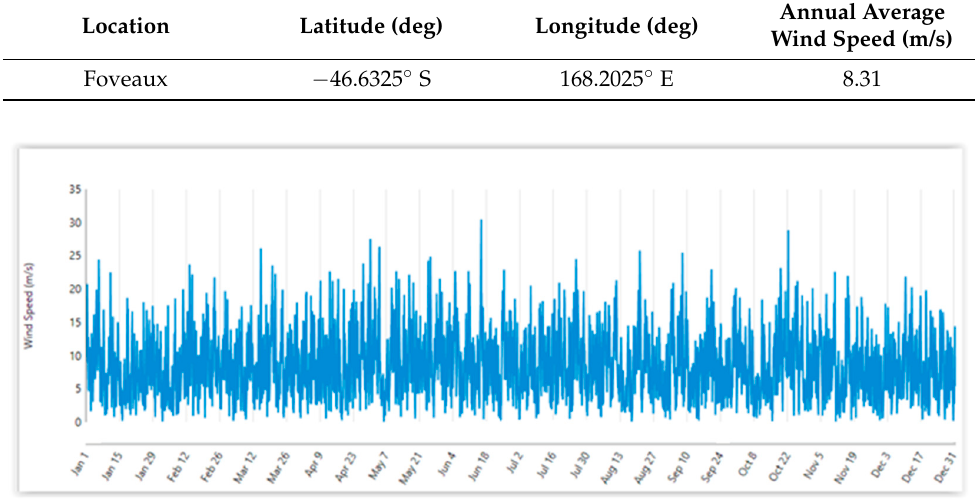
Figure 6. Annual wind speed for Foveaux site .